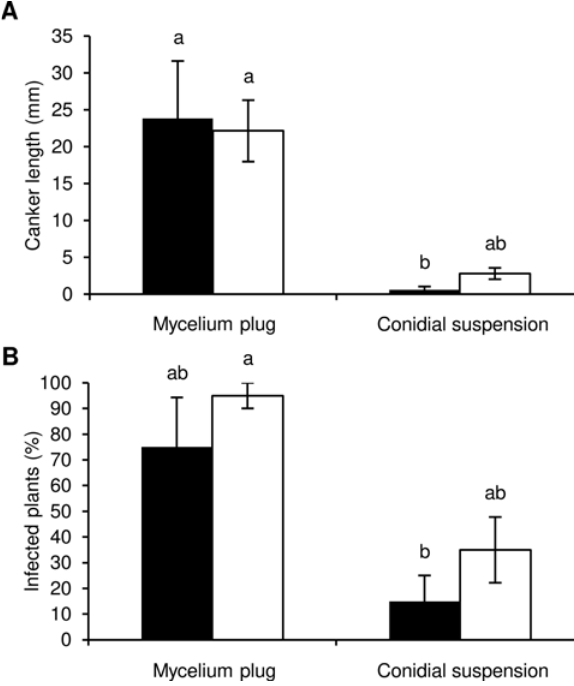
Figure 4. a) Disease severity and b) incidence caused by Diplodia seriata S, assessed, respectively, as canker lengths and as percent- age of infected plants 60 d after incubation under greenhouse con- ditions. Three-y-old trunks (black) and 1-y-old shoots (white) of apple plants were inoculated with a Diplodia seriata S mycelium plugs or conidium suspensions. Means and standard errors are shown for five replicates (plants) for each plant organ and inocu- lation procedure. Different letters indicate significant differences (Kruskal-Wallis test; P ≤